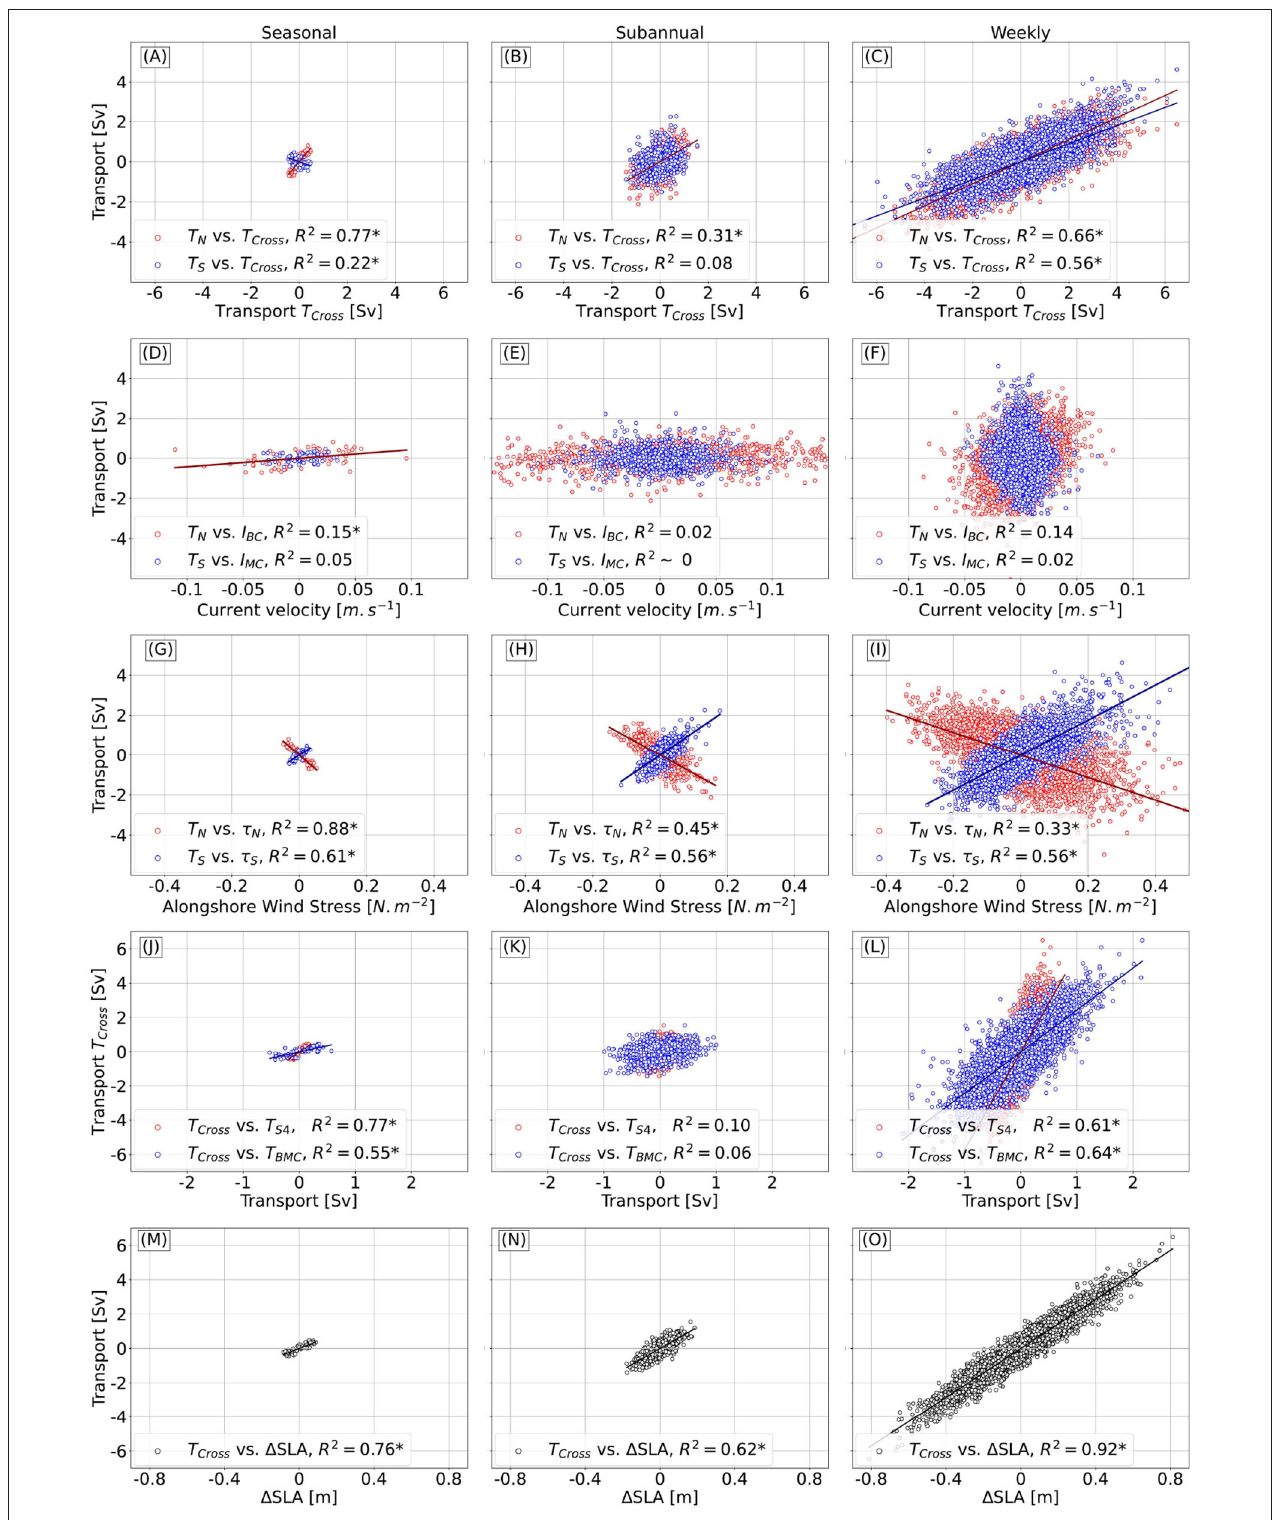
FIGURE 8 | (A–C) T N (red) and T S (blue) vs. T Cross . (D–F) T N vs. I BC (red) and T S vs. I MC (blue). (G–I) T N vs. alongshore wind stress at 30 ◦ S (red) and T S vs. alongshore wind stress at 40 ◦ S (blue). (J–L) T Cross vs. T S 4 (red) and T BMC (blue). (M–O) T Cross vs. the difference of inner shelf SLA between 40 and 30 ◦ S. (A,D,G,J,M) Seasonal scale, (B,E,H,K,N) subannual scale and (C,F,I,L,O) weekly scale.